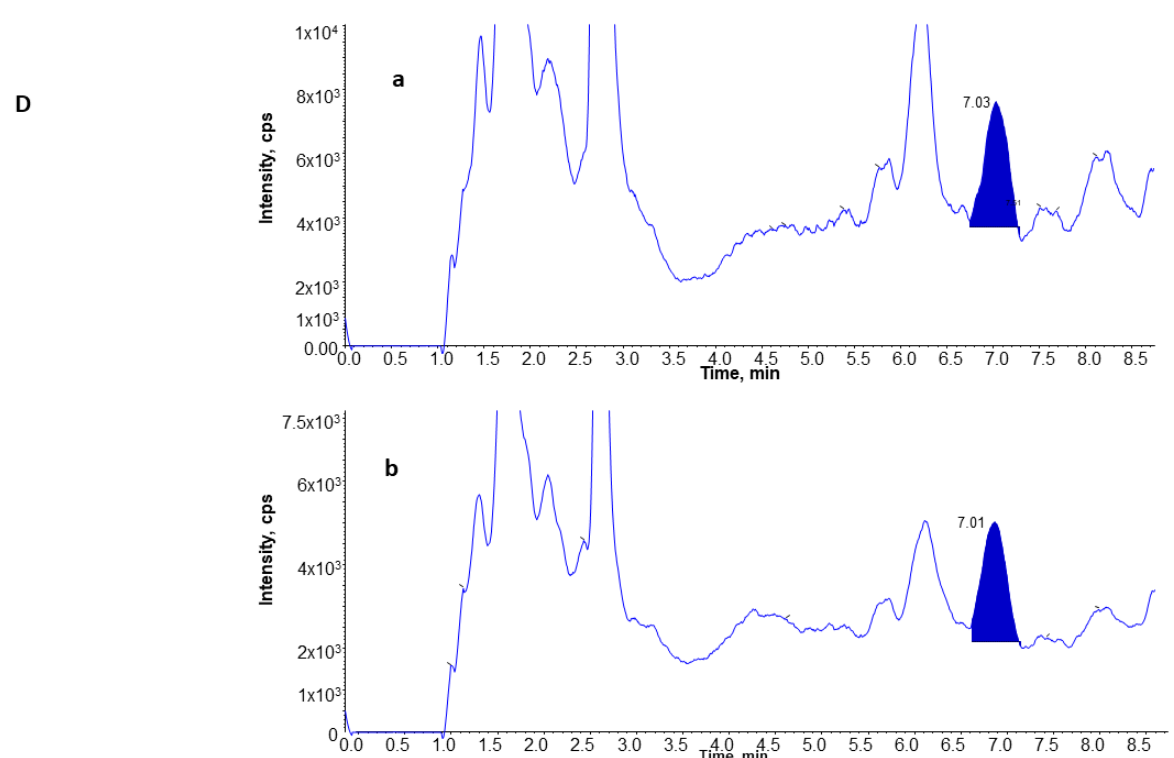
Figure 1. Chromatography of 8-isoprostane and its internal standard, 8-isoprostane-d4, in standard samples ( A ), in subjects with lung benign nodules ( B ), in lung can-cer patients ( C ), and in healthy controls ( D ). Panel a is for 8-isoprostane and panel b is for 8-isoprostane-d4 in each sample. 3.5. Levels of 8-Isoprostane in Plasma from Subjects with Lung Cancer, Benign Lung Nodules, and from